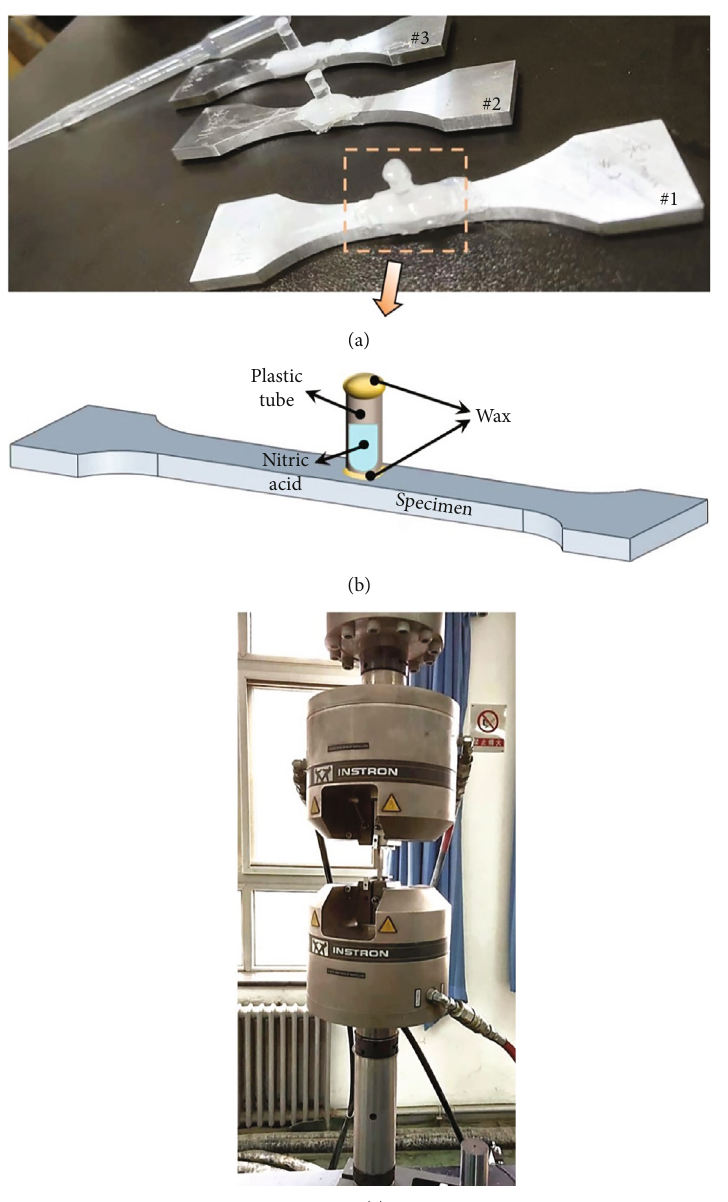
Figure 2: Corrosion and fatigue tests: (a) corrosion cell, (b) detailed schematic of (a), and (c) a fatigue